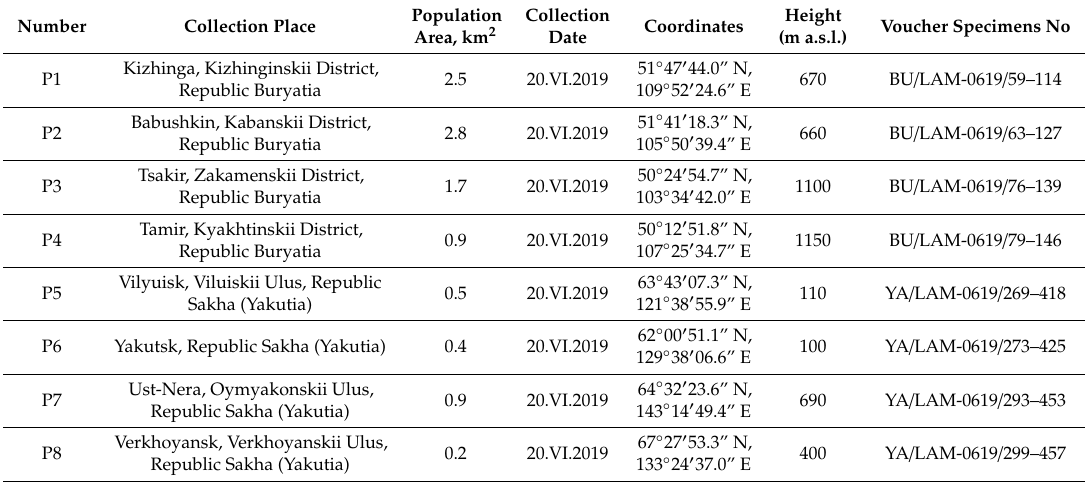
Table 7. Detailed information about Galeopsis bifida populations